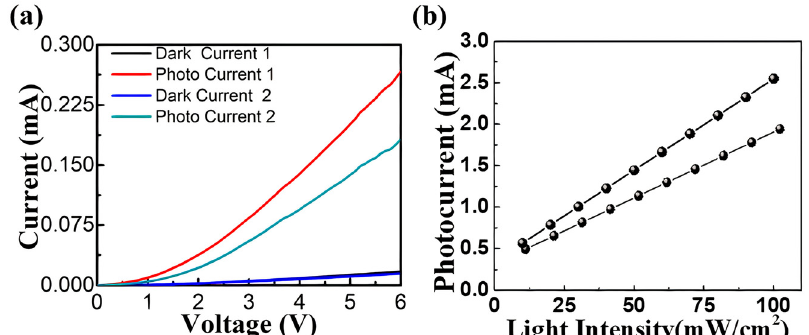
Figure 3: Opto-electronic response of the device. (a) Dark current and photocurrent of the device for both the junctions with optical excitation from 650 nm wavelength. Dark current and photocurrent 1 and 2 corresponds to CdZnO – ZnO and ZnO – MgZnO interface, respectively. (b) Photocurrent of junction 1 and 2 with respect to intensity of the incident